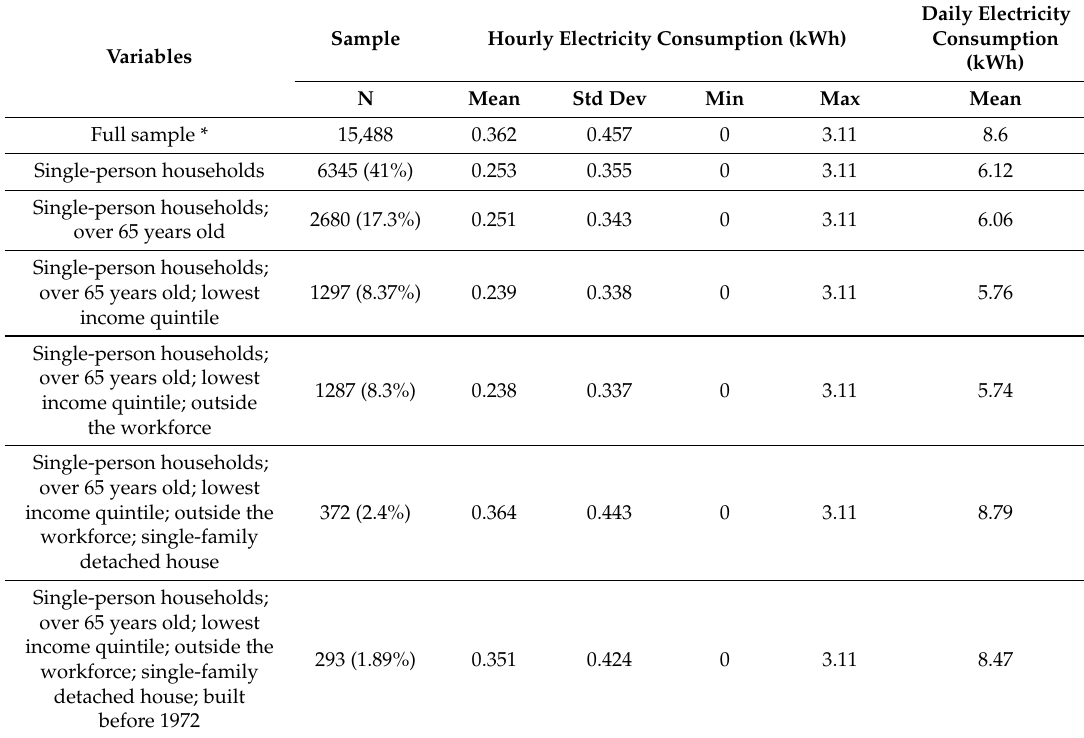
Table 1. Descriptive